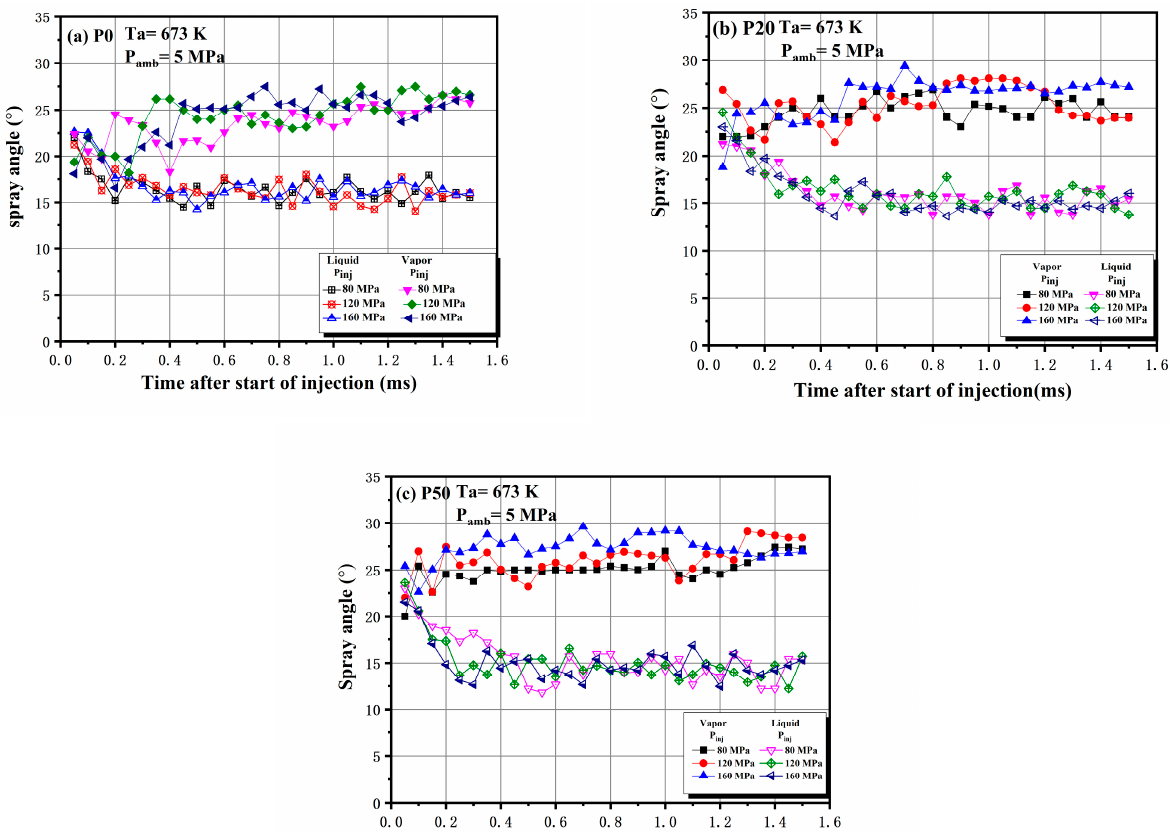
Figure 12. Cone angle of three fuels under different IPs: ( a ) P0, ( b ) P20, ( c ) P50.